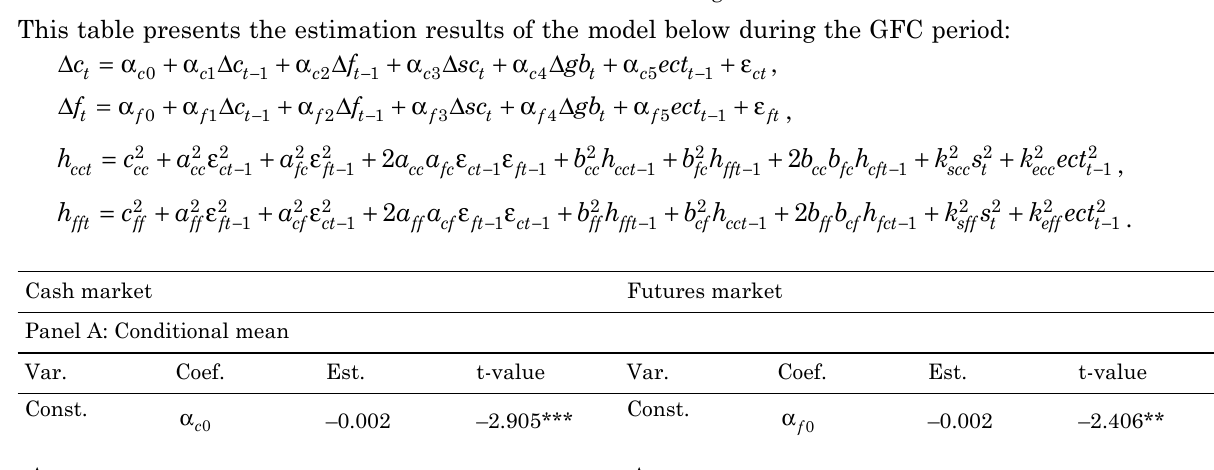
table 5. estimation of the ec-Var-BeKK-garcH-X model during the gfc this table presents the estimation results of the model below during the gfc